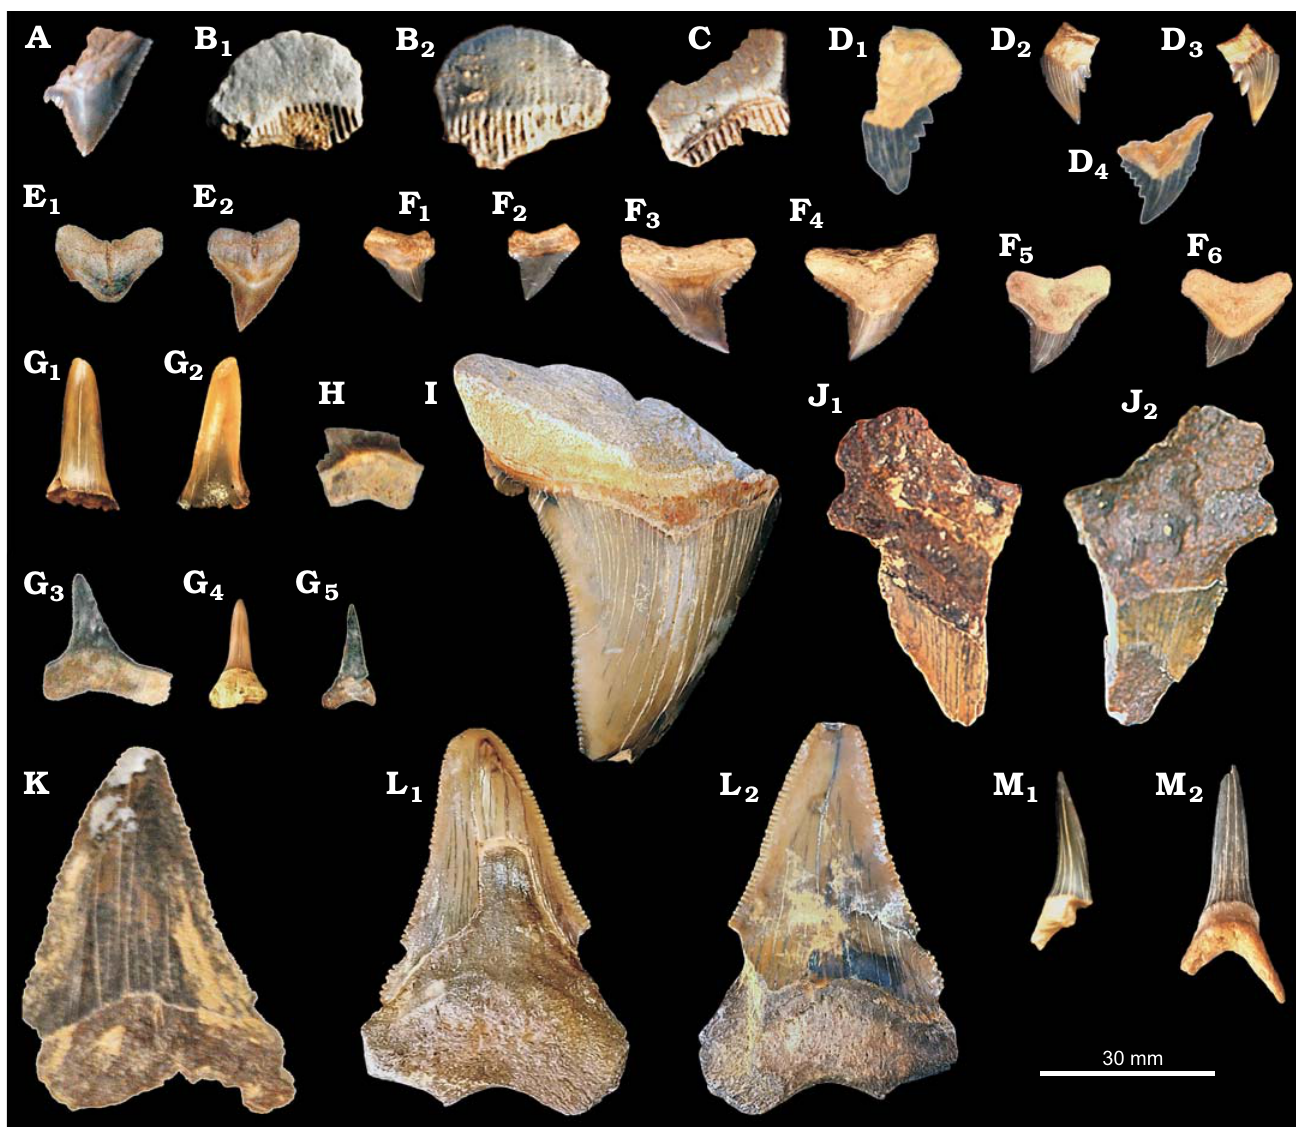
Fig. 12. A – C . Carcharhiniformes and Myliobatiformes from the BOTM, early Oligocene, Minqar Tibaghbagh, Qattara Depression, Egypt; photographed and left in the field. A . Carcha rhinus sp., incomplete upper tooth in lingual view. B , C . “ Aetobatus ” sp. B . Lower tooth in occlusal (B 1 ) and basal (B 2 ) views. C . Lower tooth in occlusal view. D – M . Carcharhiniformes and Lamniformes from the BOS, early Oligocene, Minqar Tibaghbagh, Qattara Depression, Egypt. D . Hemipristis cf. serra Agassiz, 1835 (1843) (CGM67195), upper lateral teeth in lingual (D 1 , D 2 , D 4 ) and labial (D 3 ) views. E . Carcharhinus cf.